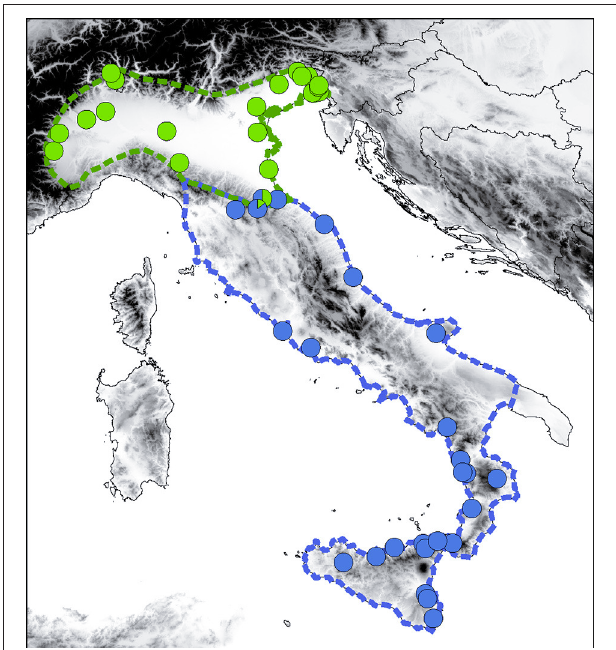
FIGURE 3 | Distribution of the mitochondrial lineages of H. perrini sp. nov. (green) and H. intermedia s. s. (blue) across their natural ranges, based on records from previous studies. Dashed lines delineate range margins. The map was built in QGIS 2.18 using map layers from ESRI.